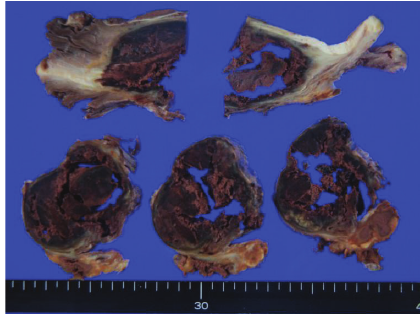
Figure 3: Macroscopic findings. Macroscopic findings revealed diffuse necrosis of tibialis anterior and extensor hallucis longus muscles.